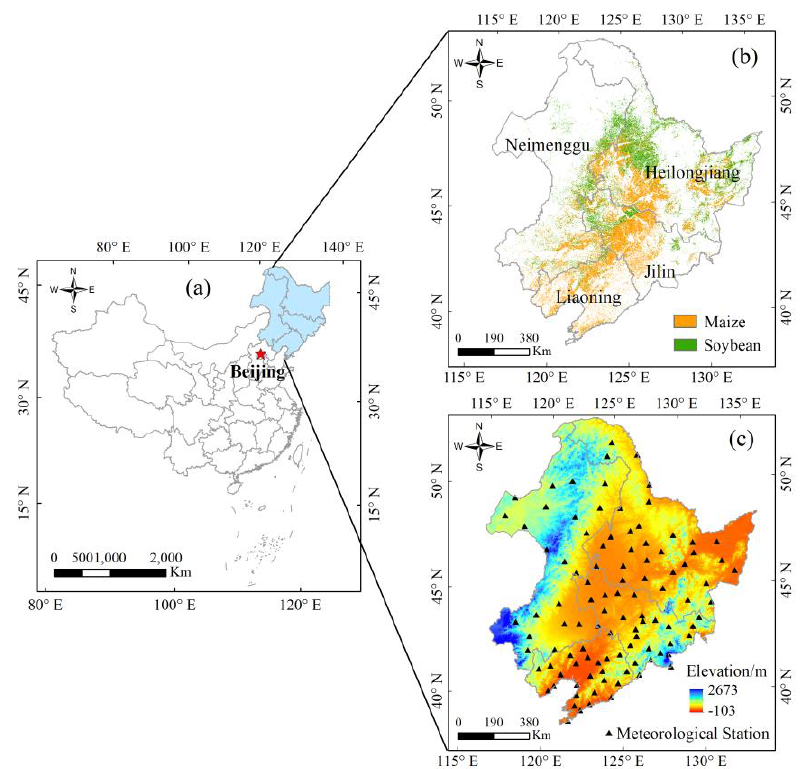
Figure 1. The study area. ( a ) Geographical position of Northeast China; ( b ) main upland crop types and range in Northeast China; and ( c ) digital elevation model data (DEM) and the meteorological stations in Northeast China.